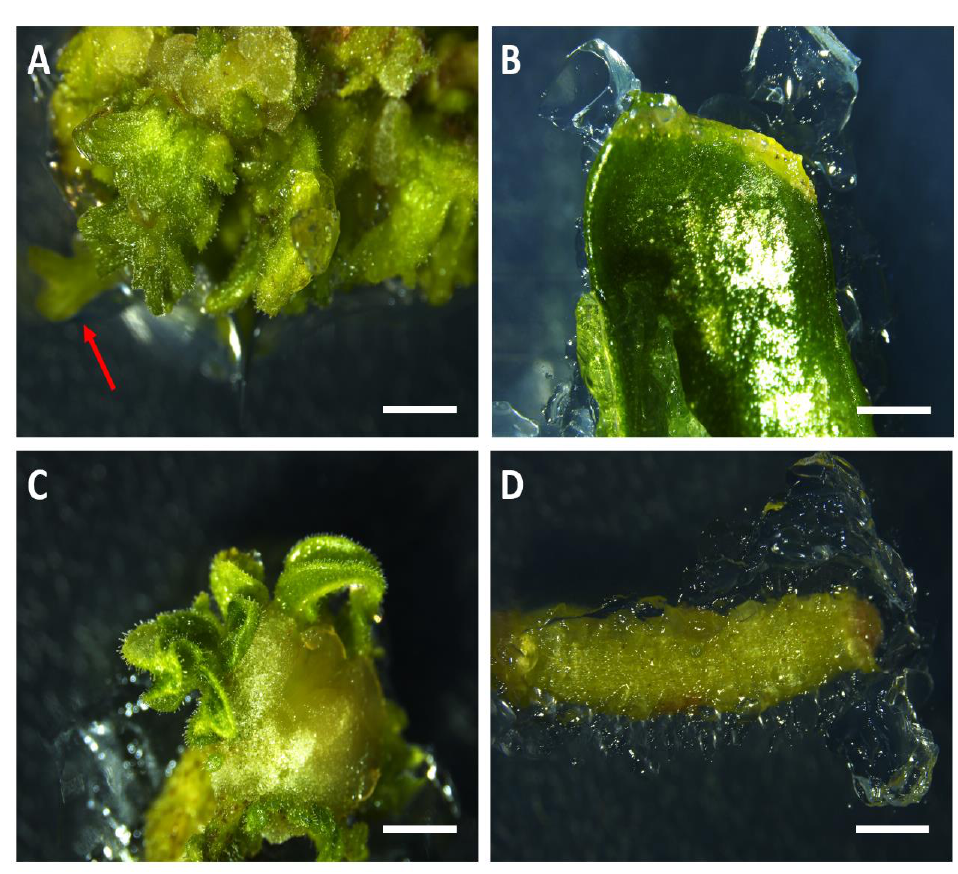
Figure 3. Comparison of shoot formation between Pep1 + Pep1.2 and control media in cotyledon and hypocotyl of C. baccatum after one month of culture. ( A ) Cotyledon with high organogenic response levels (the red arrow indicates the formation of a developed shoot). ( B ) Cotyledon with no organogenic response. ( C ) Hypocotyl with high organogenic response levels. ( D ) Hypocotyl with no organogenic response. The size of the bars is 5